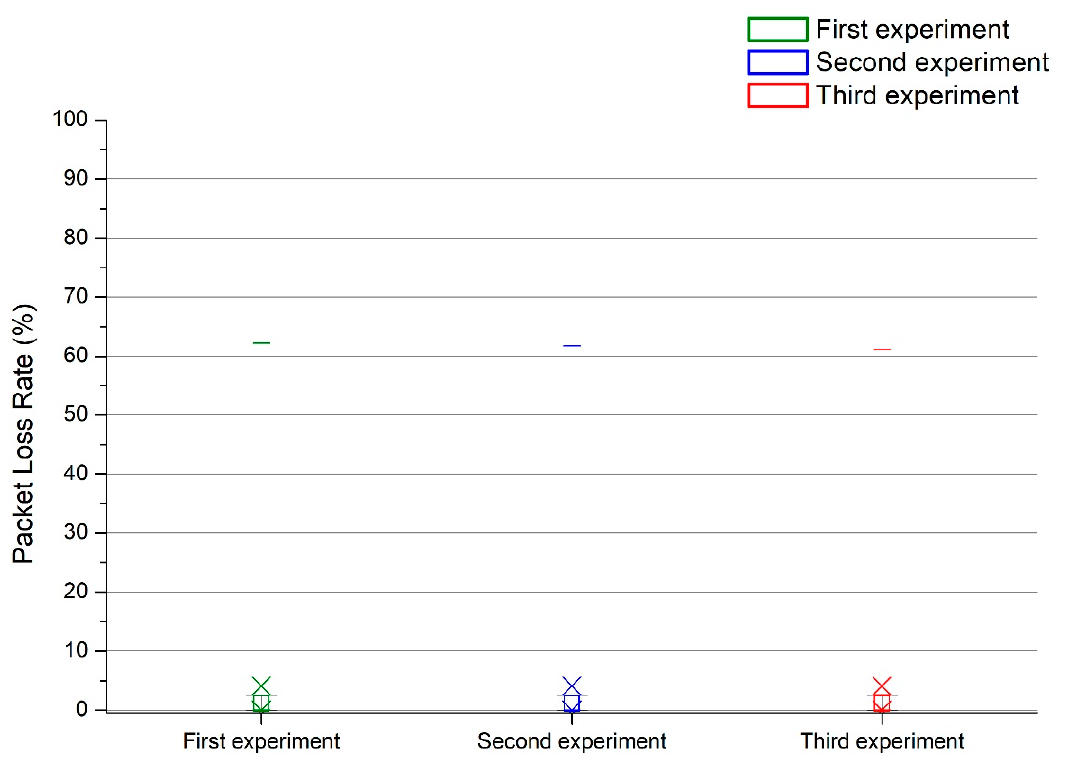
Figure 23. The confidence interval of packet loss rates of the three experimental results for the proposed deep-learning-based handover mechanism.